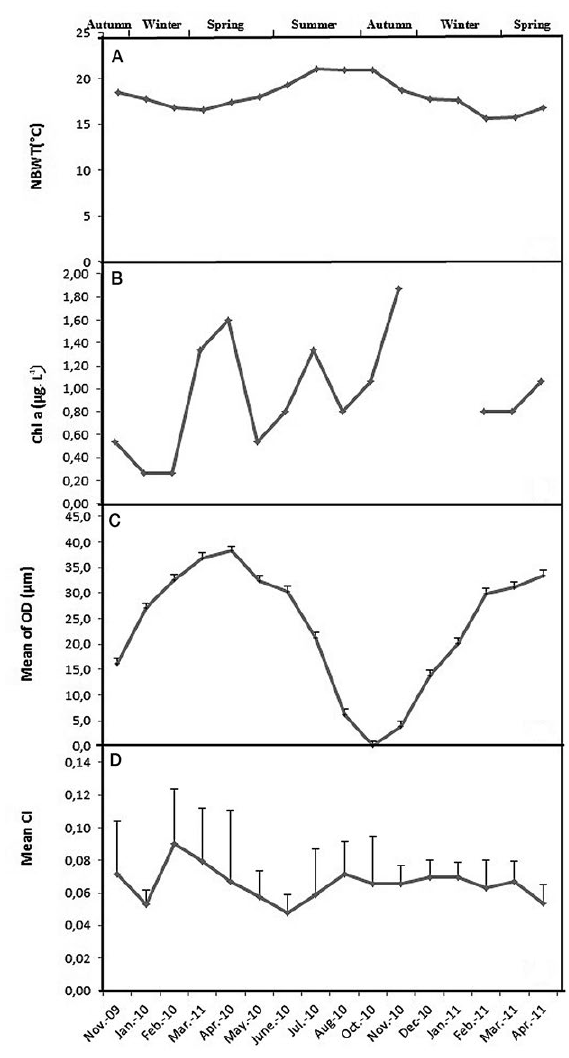
Fig. 5. – Correlations between monthly environmental parameters and gametogenic descriptors for A. tuberculata at M’diq Bay (SW Mediterranean Sea): A, near-bottom water temperature; B, changes in concentration of chlorophyll a in near-bottom sea water; C, mean oocyte diameter (OD); D, mean condition index